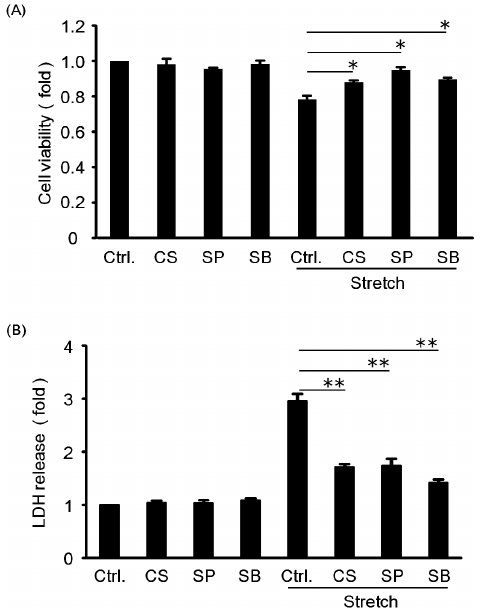
Figure 4. Comparison of the cell viability (A) and LDH release (B) induced by cyclic mechanical stretch in RASMCs with or without azelnidipine or MAP kinase inhibitors. The cells were pre-incubated by CS905 (100 nM), SP600125 (20 m M), and SB203580 (20 m M) for 20 min prior to exposing to cyclic mechanical stretch by 15% elongation for 4 h and then incubated for 24 h. Cell viability and cell death were evaluated by MTT assay and the release of lactate dehydrogenase (LDH), respectively. Azelnidipine (CS905), SP600125, and SB203580 are abbreviated as CS, SP, and SB. Colorimetric analysis of each value was normalized by arbitrarily setting the absorbance value of the control cells (Ctrl.) to 1. Each value represents the mean 6 S.D. (n=4). The asterisks represent significant differences compared with the stretched control value (* P , 0.05, ** P , 0.01).